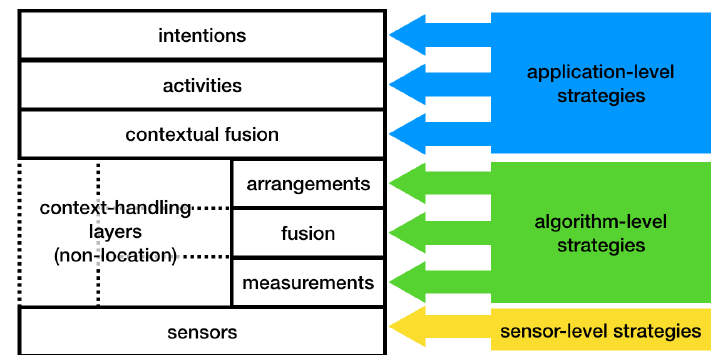
Figure 5. Three classes of adaptation strategies to mitigate variations in the quality of location information aligned with the layers of the Location Stack model from